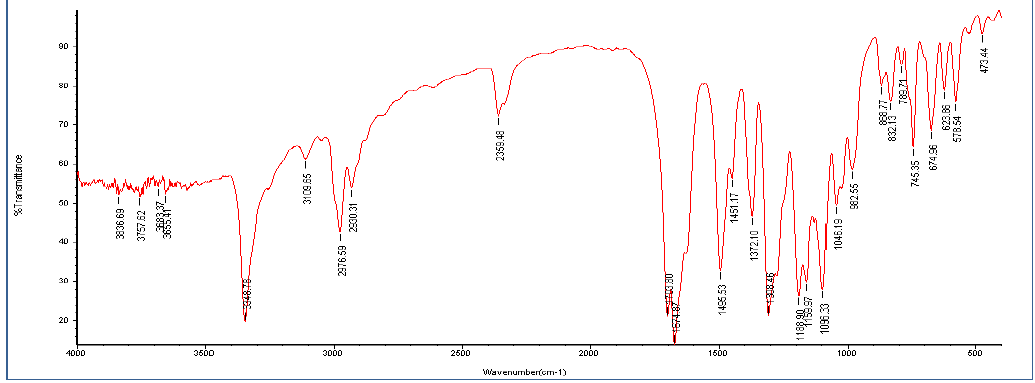
Figure11.The FTIR spectrum of LCDP .